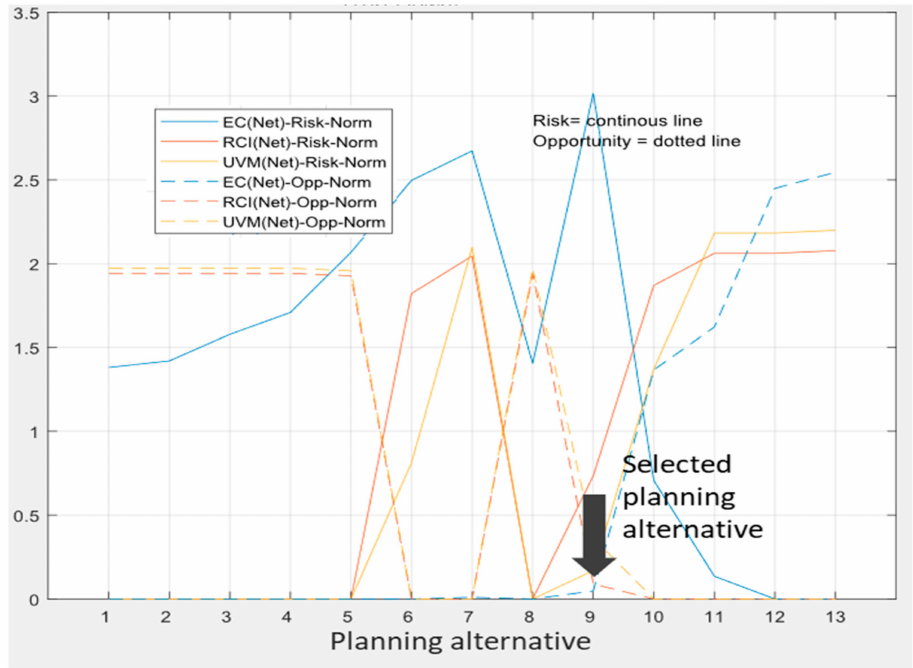
Figure 8. Normalized risks (Risk-Norm) and opportunities (Opp-Norm) of planning alternatives by objectives in terms of distance, in standard deviations, from the lowest risk /